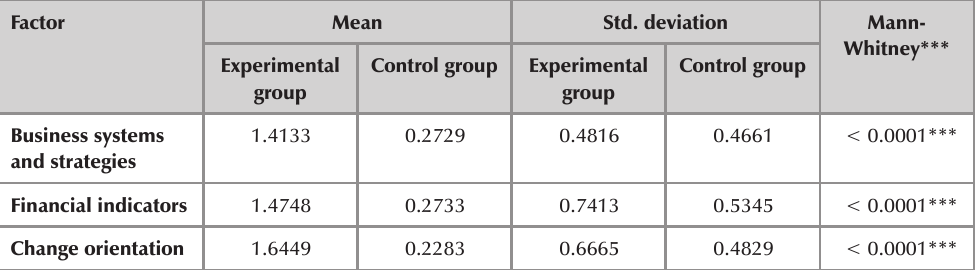
Independent t-test: Comparison of the experimental and control groups after the WEP on the three business improvement factors Std.